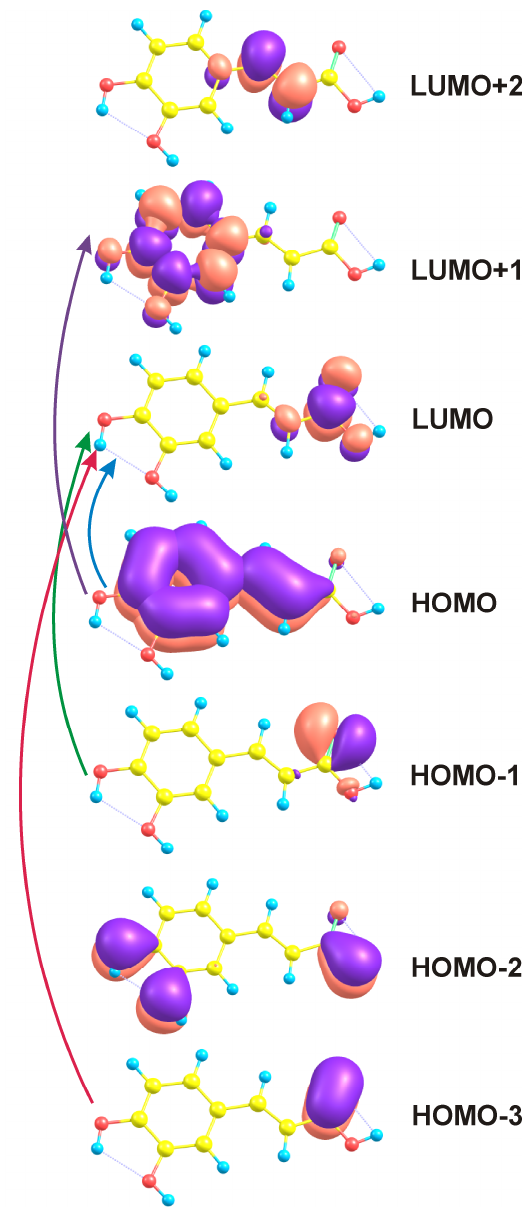
Figure 4. The NLMO clusters of caffeic acid. The arrows connect molecular moieties involved in electronic